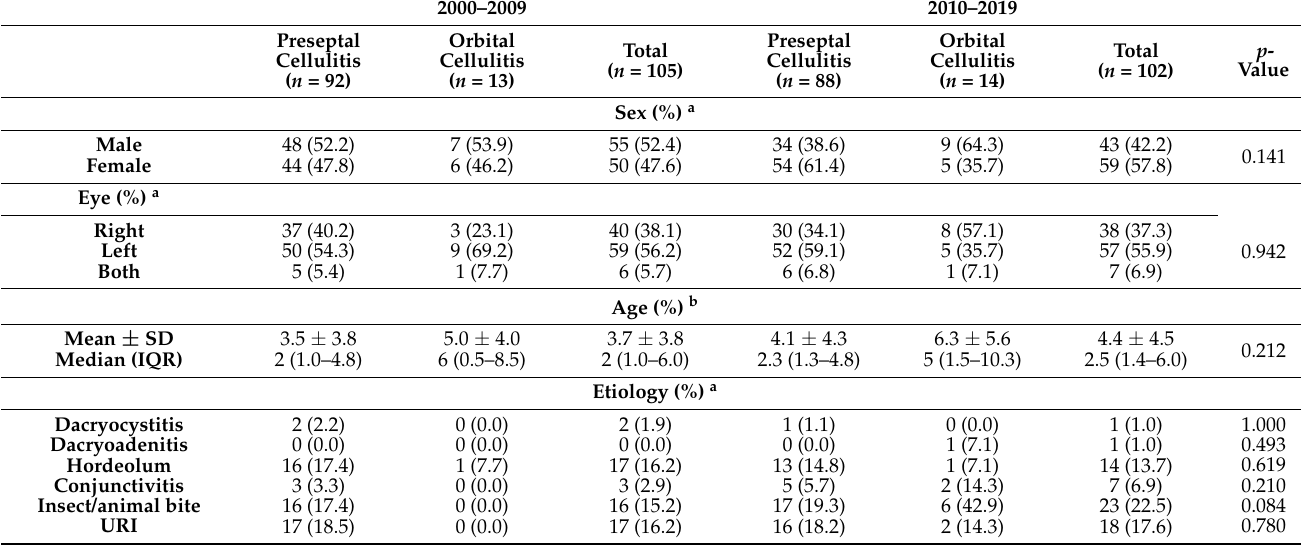
Table 1. Demographics and characteristics of patients with preseptal or orbital